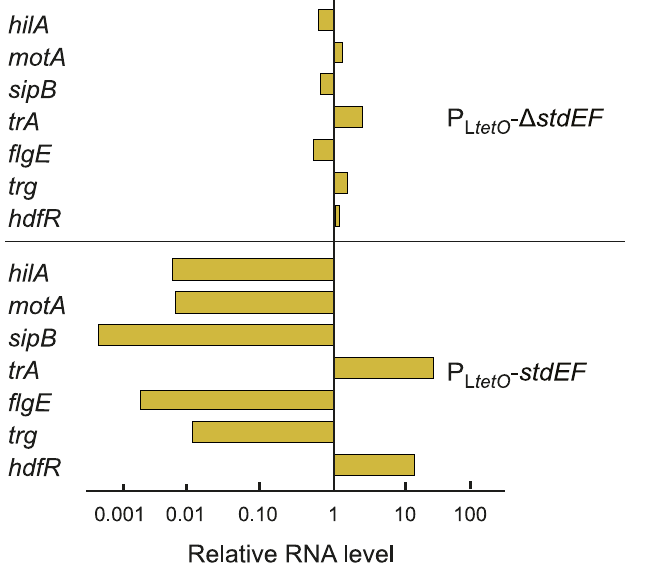
Fig 2. Validation of microarray data. RNA levels of some of the genes under StdEF control identified by microarray analysis in strains P L tetO - stdEF (SV8141) and P L tetO - Δ stdEF (SV8142). For each locus, data are normalized to the RNA level obtained in the wild type (which was set to "1" in all cases). The RNA levels were determined in (cid:21) 3 biological replicates, and a representative experiment is